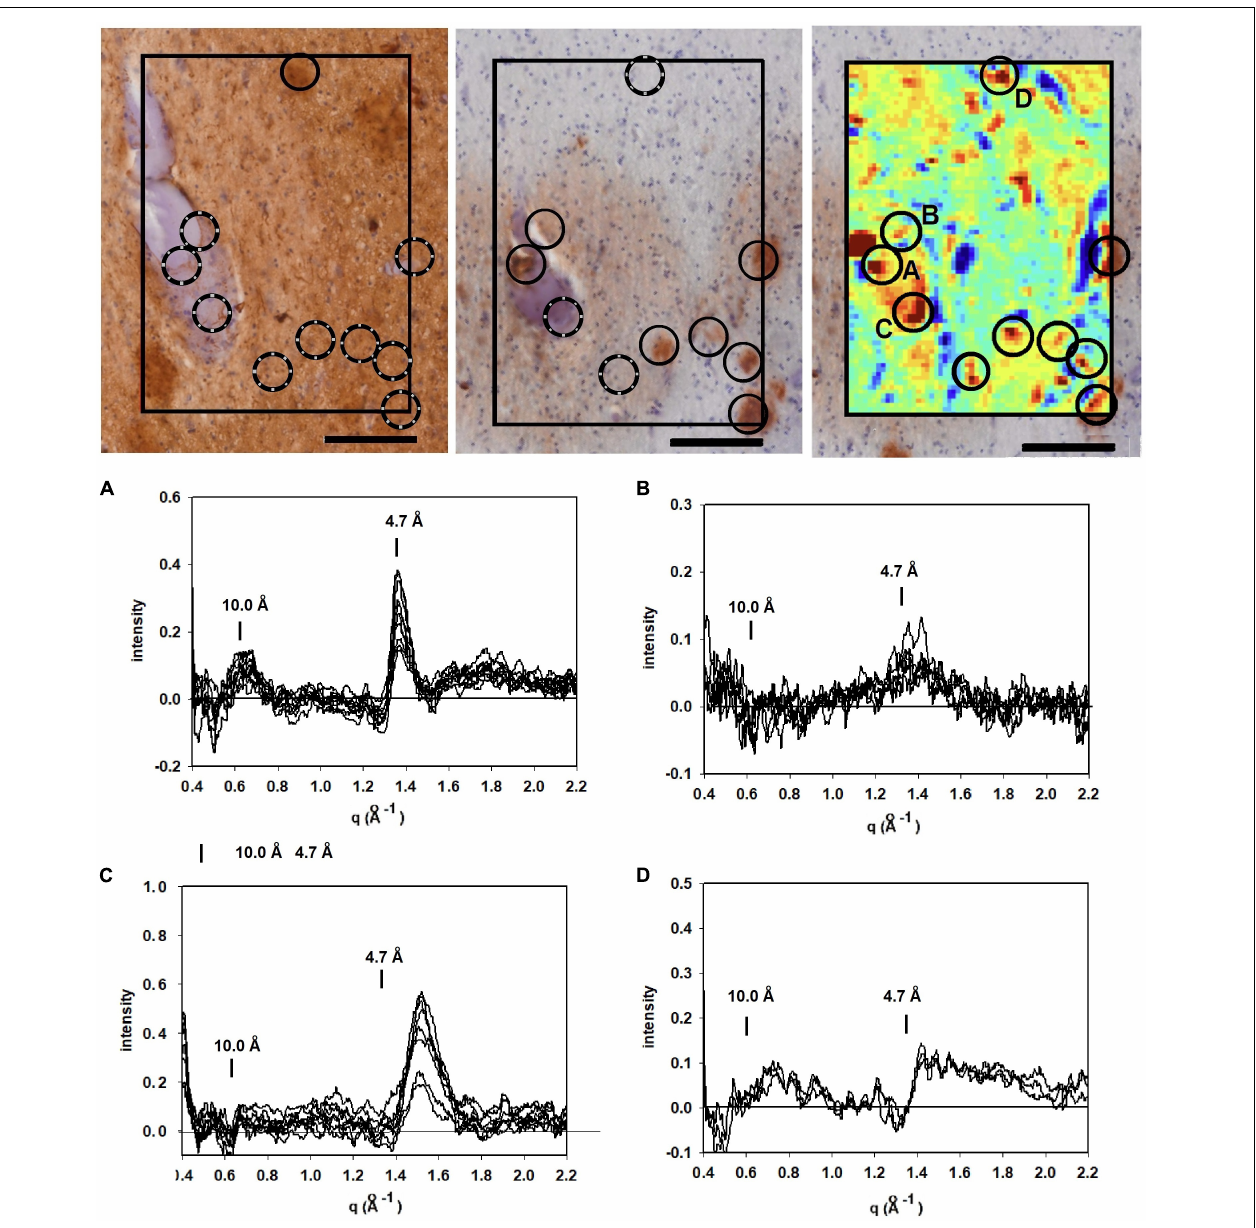
FIGURE 3 | Images of serial sections of amygdala immunostained for tau (left); and A β (middle) compared with (right) a mapping of the 4.7 Å intensity observed from an unstained serial section (sequence of sections collected were tau → unstained → A β ). Selected common features are marked by circles. Lesions seen in the heat map but missing in the stained section are indicated by broken circles. (A–D) WAXS scattering intensity from multiple patterns collected from each of four of the prominent features (features A–D in the x-ray map) are exhibited below. Scale bar 100 µ